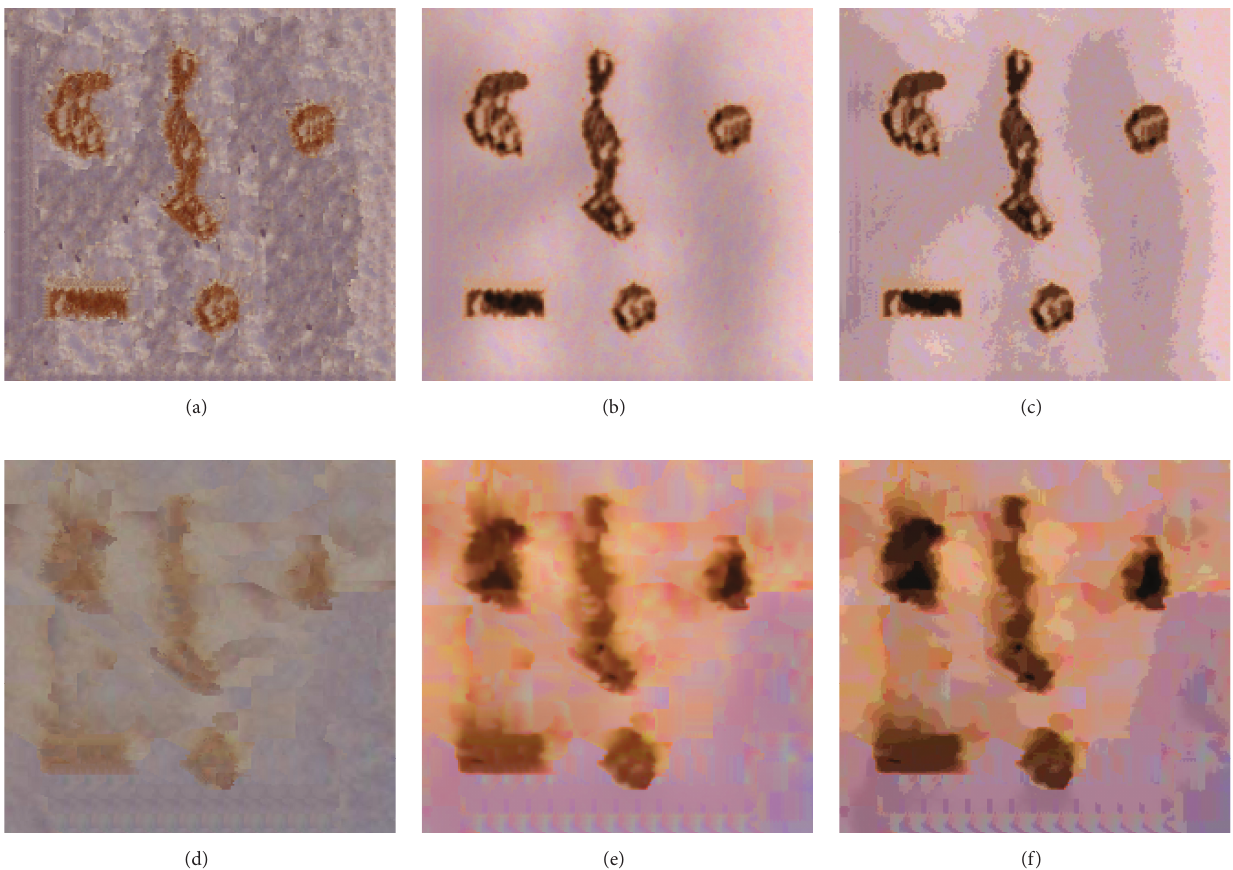
Figure 7: Synthetic vascular images. Abstraction results: original images (left), reconstructed images of the color layer of the original images, large-scale, and detailed layers (median), and salient blood vessel region abstraction from our proposed filtering method (right).